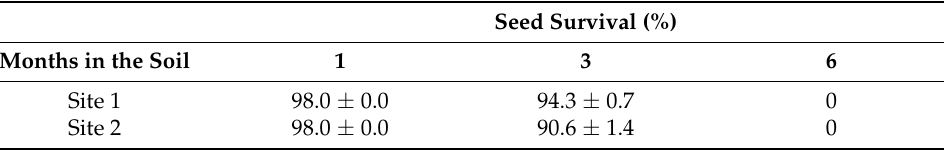
Table 3. Percentage (mean ± SE) survival of Pyracantha angustifolia seeds after being buried in the soil for up to six months at two field